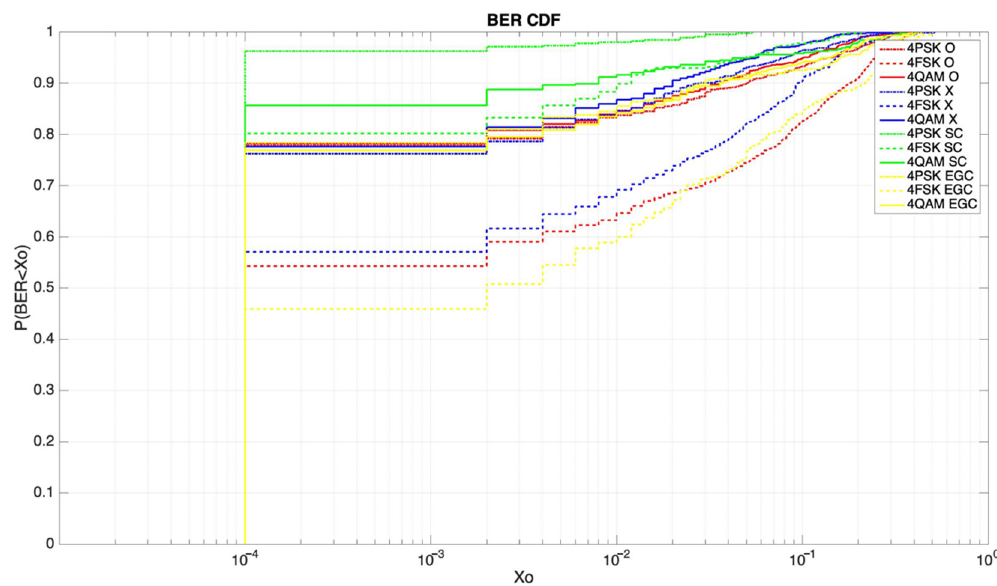
Figure 15. Cumulative distribution function (CDF) of the bit error rate for fourth-order modulations at 50 W.